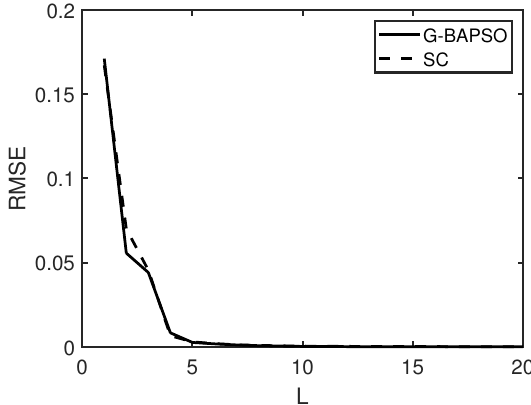
Figure 8. The average convergence curve (Dataset 2).